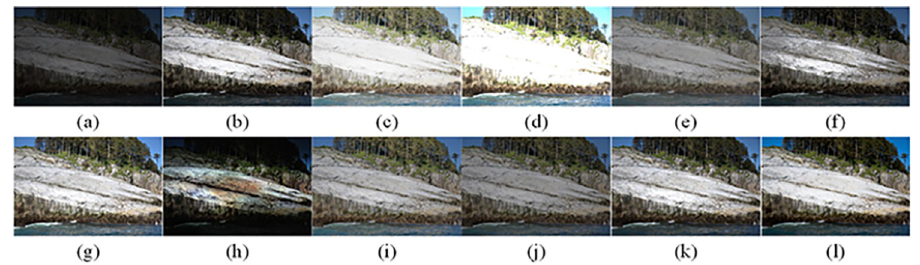
Fig 12. Comparisons of the ten algorithms in enhancing low-light image 2. (a) low-light image (b) AGCWD (c) Al- Ameen (d) BHE2PL (e) BIMEF (f) BPDHE (g) LIME (h) MSRCR (i) NPEA (j) SRIE (k) OURS (l) Normal light image.